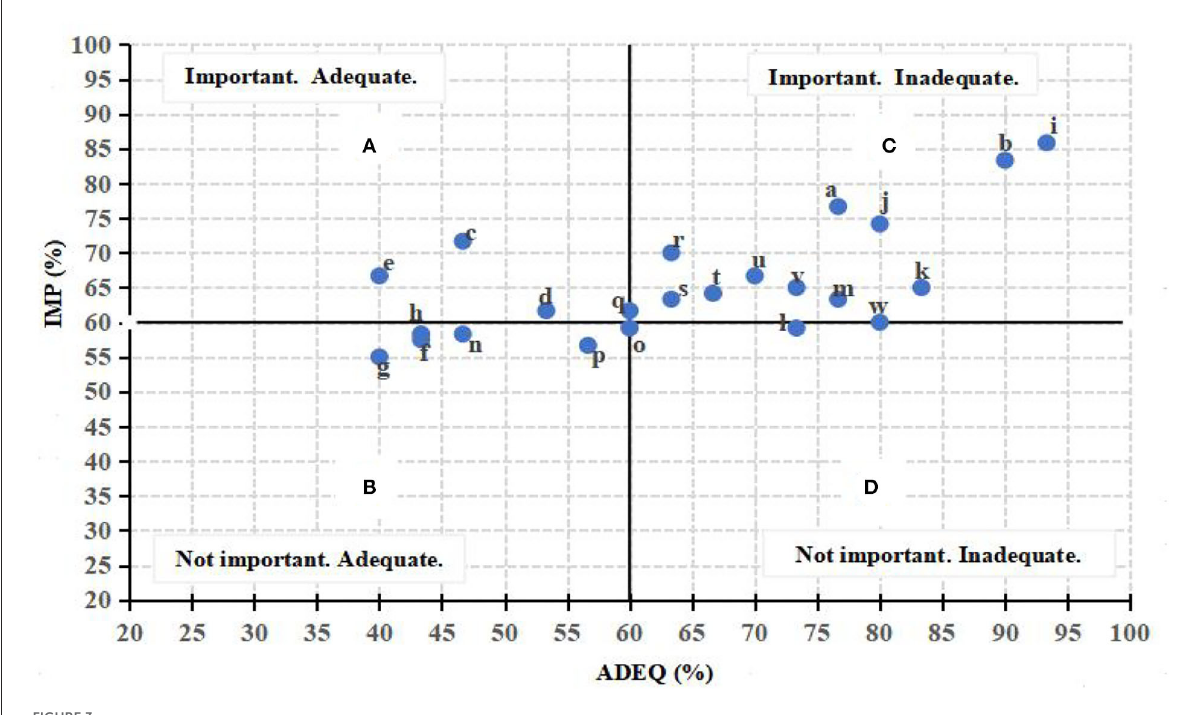
FIGURE3 A scatterplot of the interpreter competence